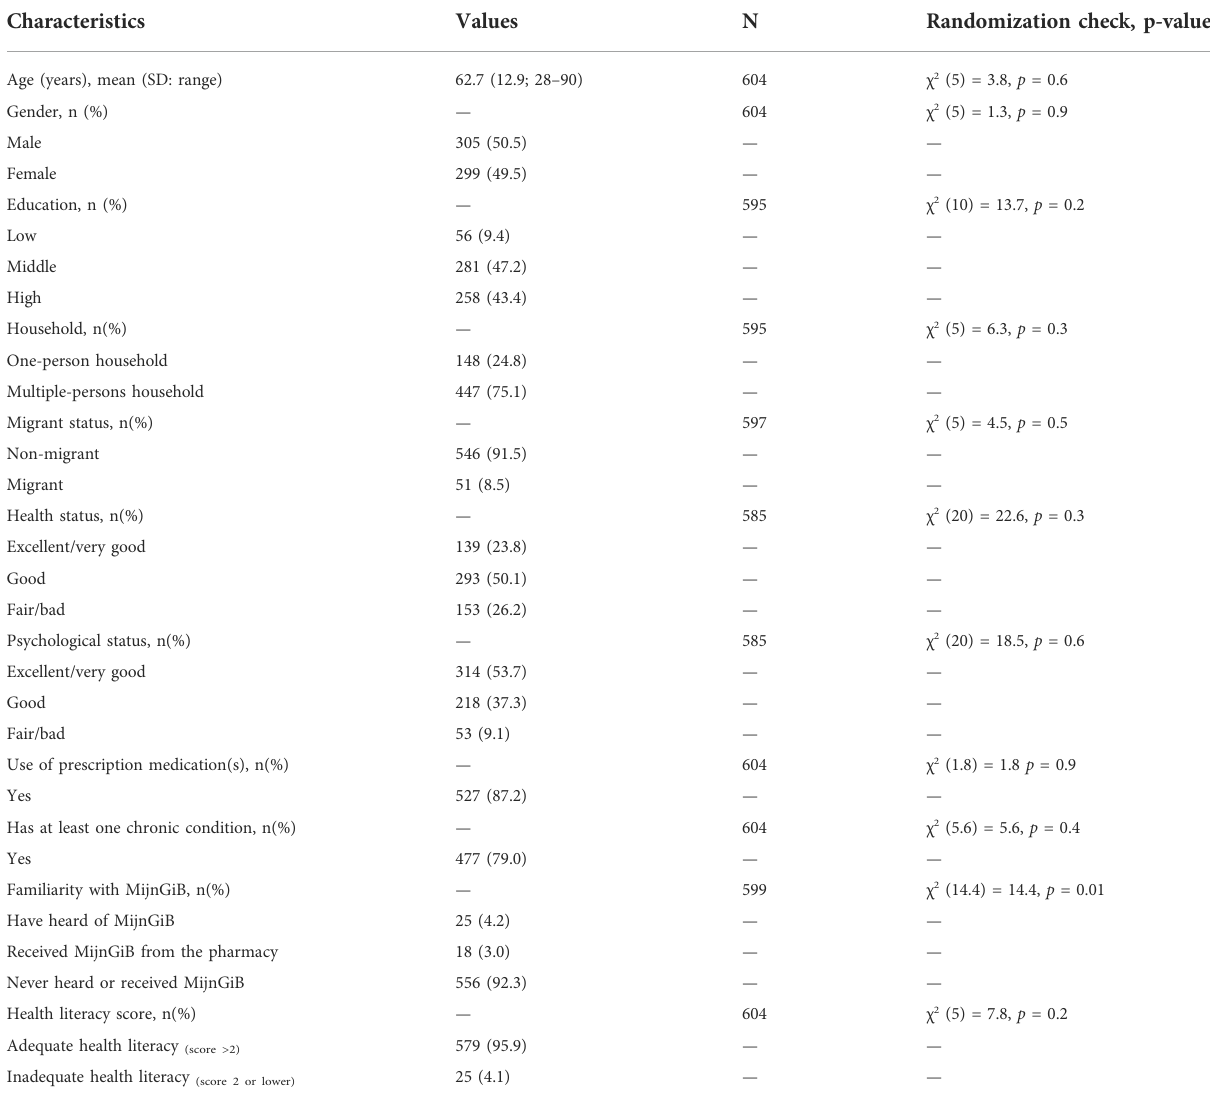
TABLE 2 Background characteristics of respondents (N = 604).